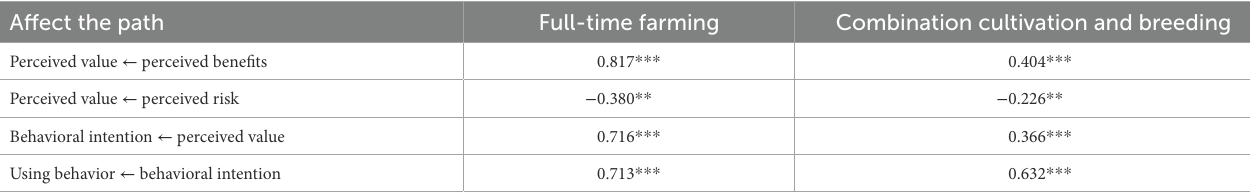
TABLE 7 The result of Multi-group model